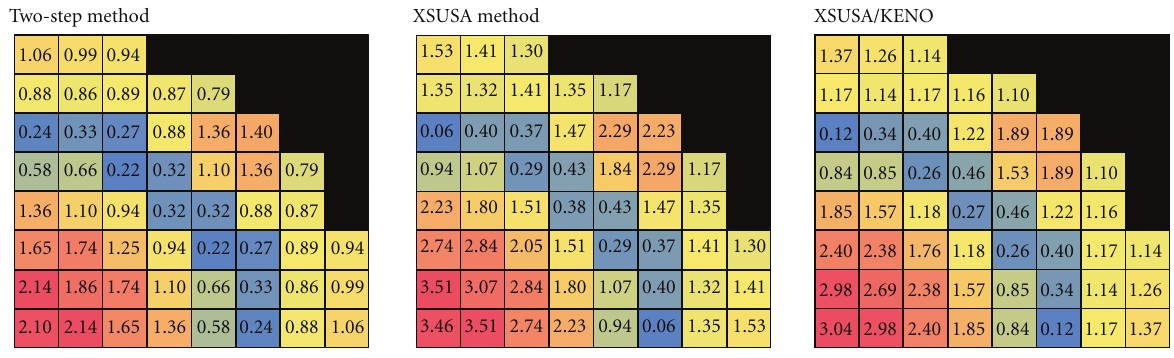
Figure 6: Relative standard deviation (%) calculated by the two-step and XSUSA methods along with the XSUSA/KENO reference. Uncertainties in assembly discontinuity factors are included. Quarter symmetry is displayed.